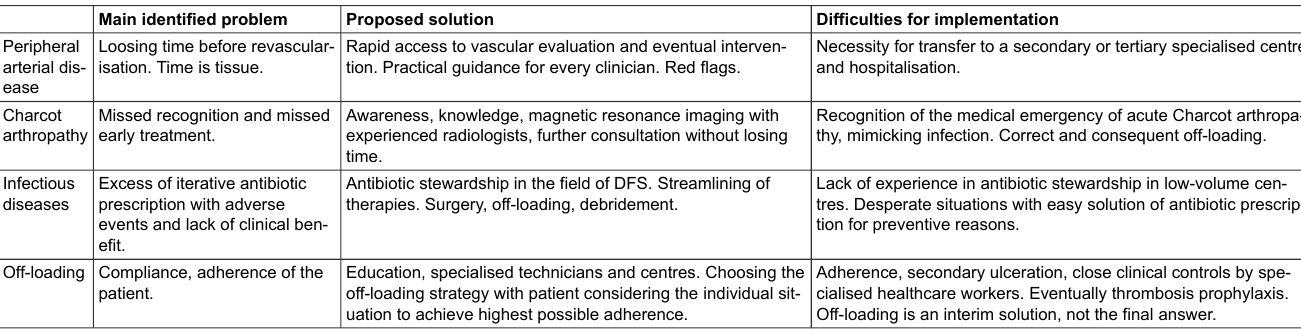
Table 2: Proposed requirements for specialised diabetic foot syndrome (DFS) centres in Switzerland. Level of